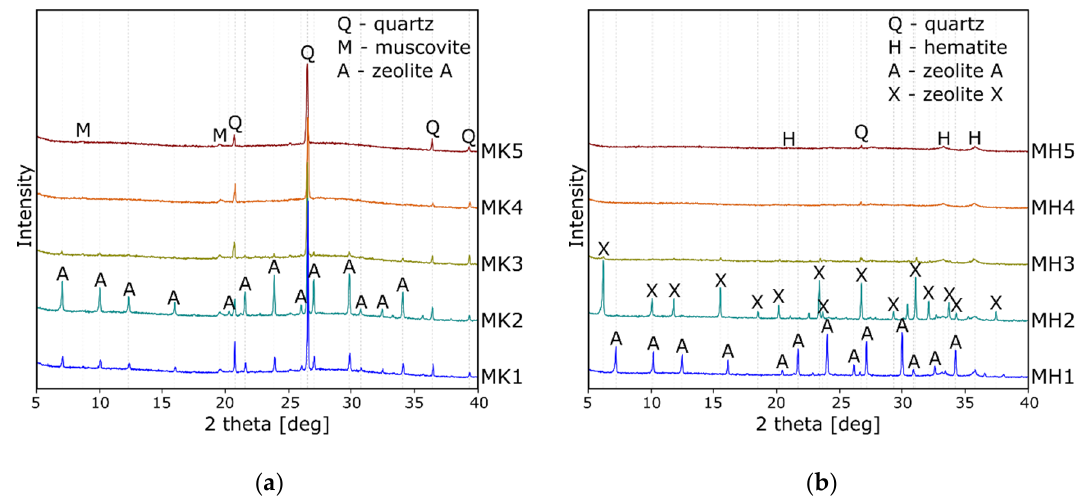
Figure 3. The XRD patterns of alkali-activated: ( a ) metakaolin; ( b ) metahalloysite.